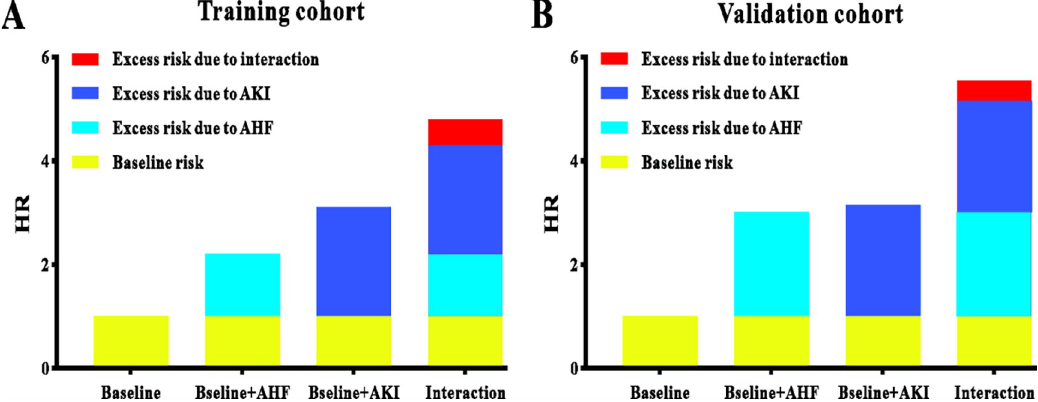
Fig 4. Relative risk with contributions from acute heart failure, acute kidney injury, or a combination of both ( A ) in the training cohort and ( B ) in the validation cohort.